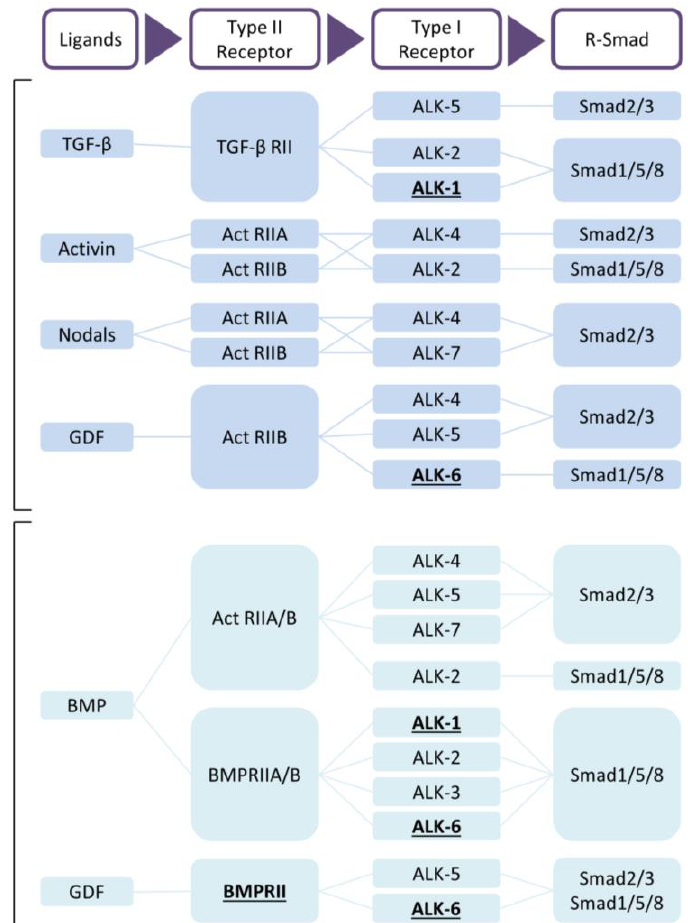
Figure 1. TGF‐β and BMP signaling. Receptors with evidence of mutations in pulmonary arterial hypertension (PAH) are underlined [17]. Abbreviations: ActRII, activin receptor type II; ALK, activing receptor‐like kinase; BMP, bone morphogenetic protein; GDF, growth/differentiation factor; TGF, transforming growth factor.